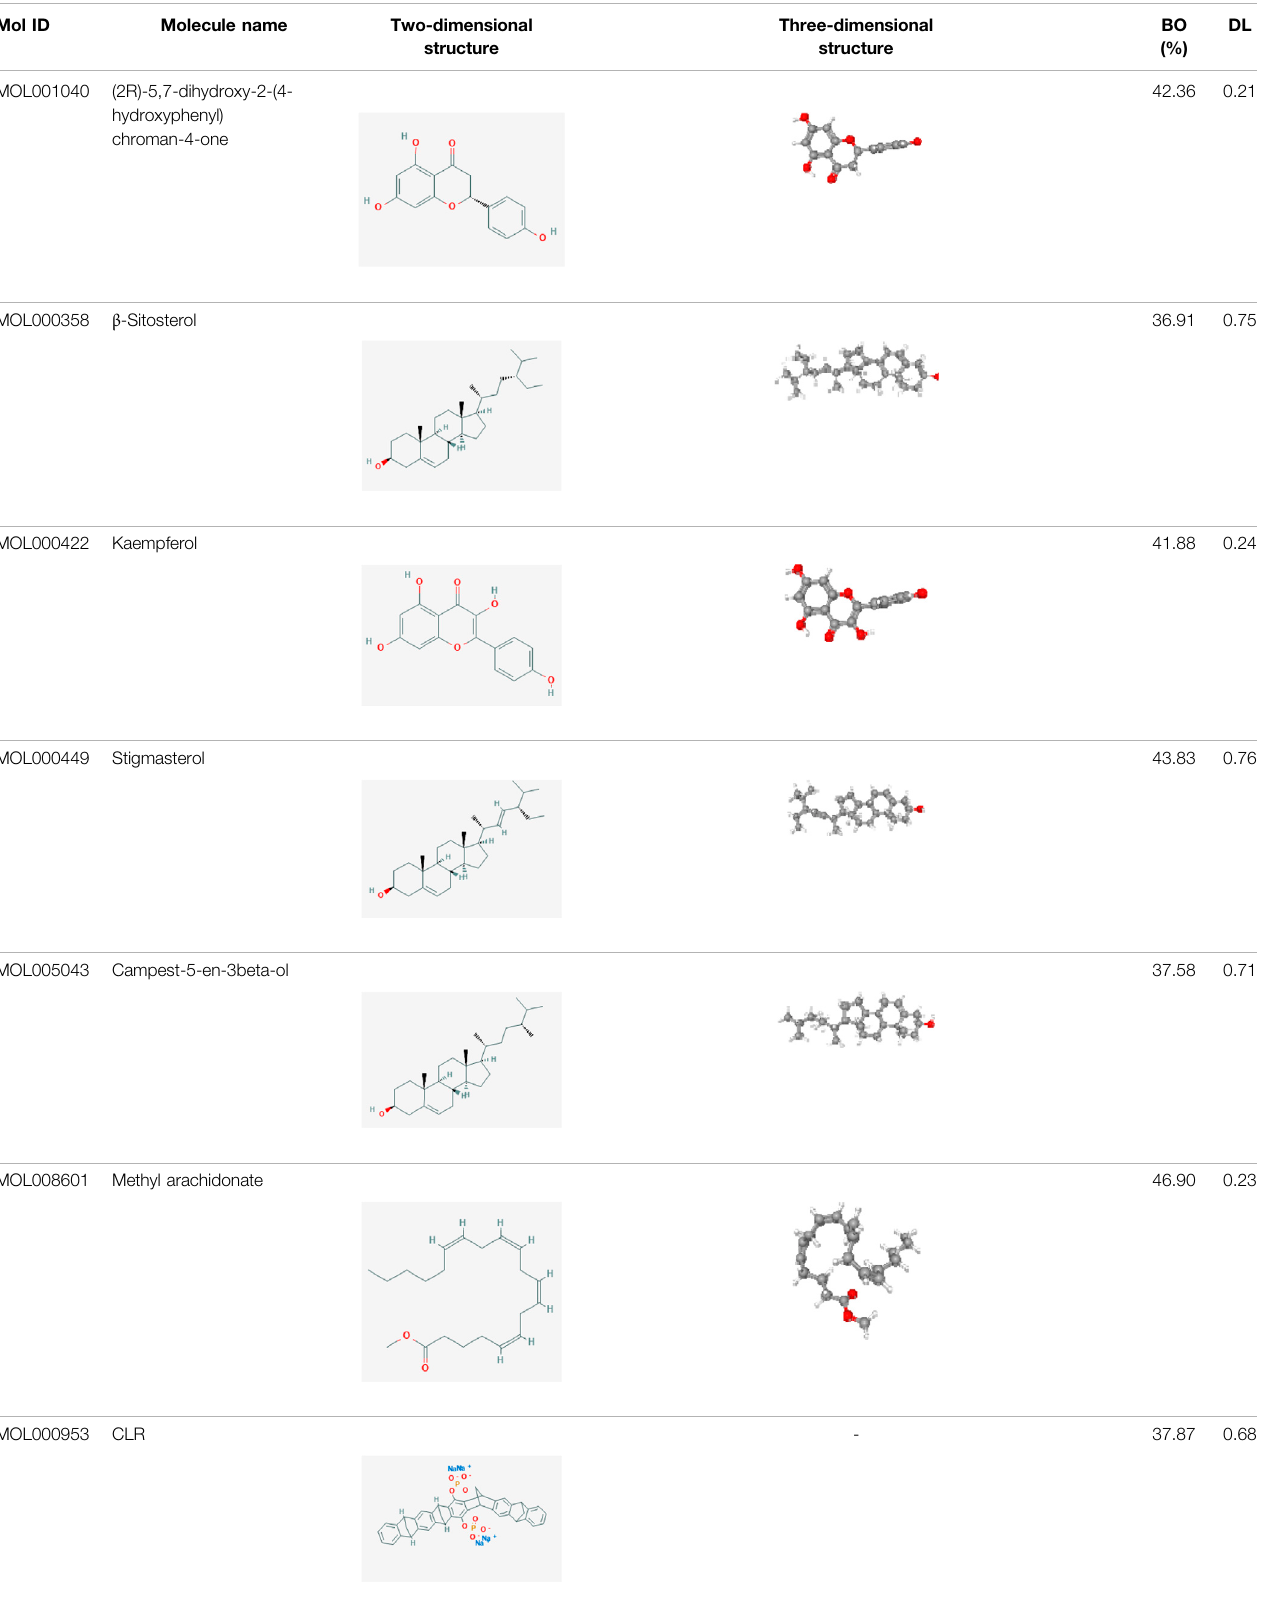
TABLE 2 | Eight main active ingredients of PM screened from TCMSP